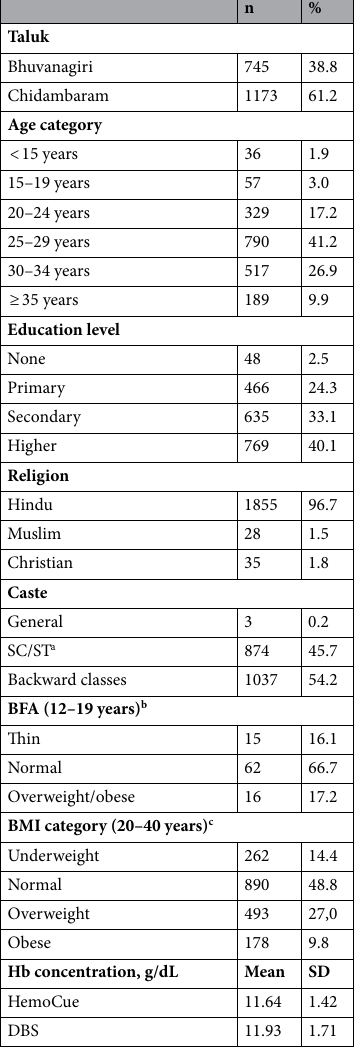
Table 1. Sociodemographic characteristics and nutrition status of females 12–40 years (n = 1918). a